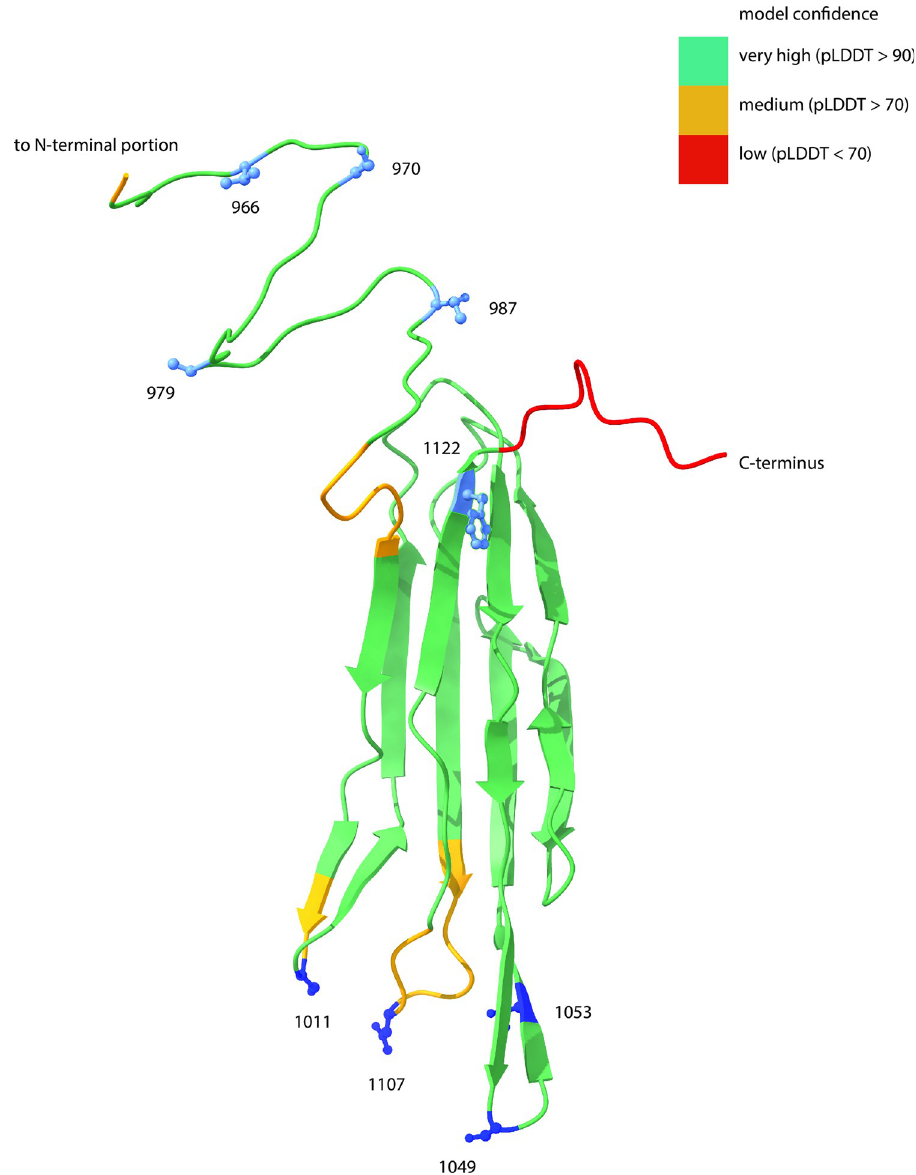
Fig 4. Mapping thermostabilizing and putative destabilizing mutations on a structural prediction of J’s reactive region. We used Alphafold [31] to predict the structure of the reactive region of J (amino acids 960–1132). This structure corresponds to the 6-mut genotype, but the 6-mut prediction was nearly identical to the ancestor prediction (S2 Fig). We then mapped the surface binding mutations (dark blue residues) and the thermostabilizing and destabilizing mutations (light blue residues) onto the structure. Coloration of the backbone indicates model